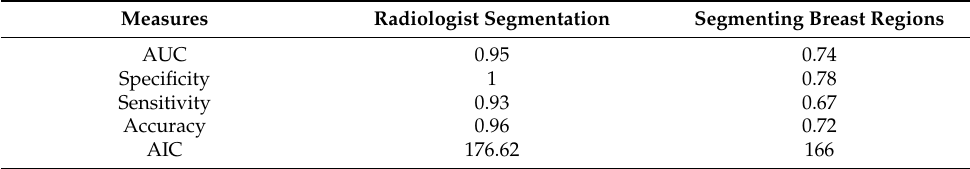
Table 6. Comparison between models with MS1 and